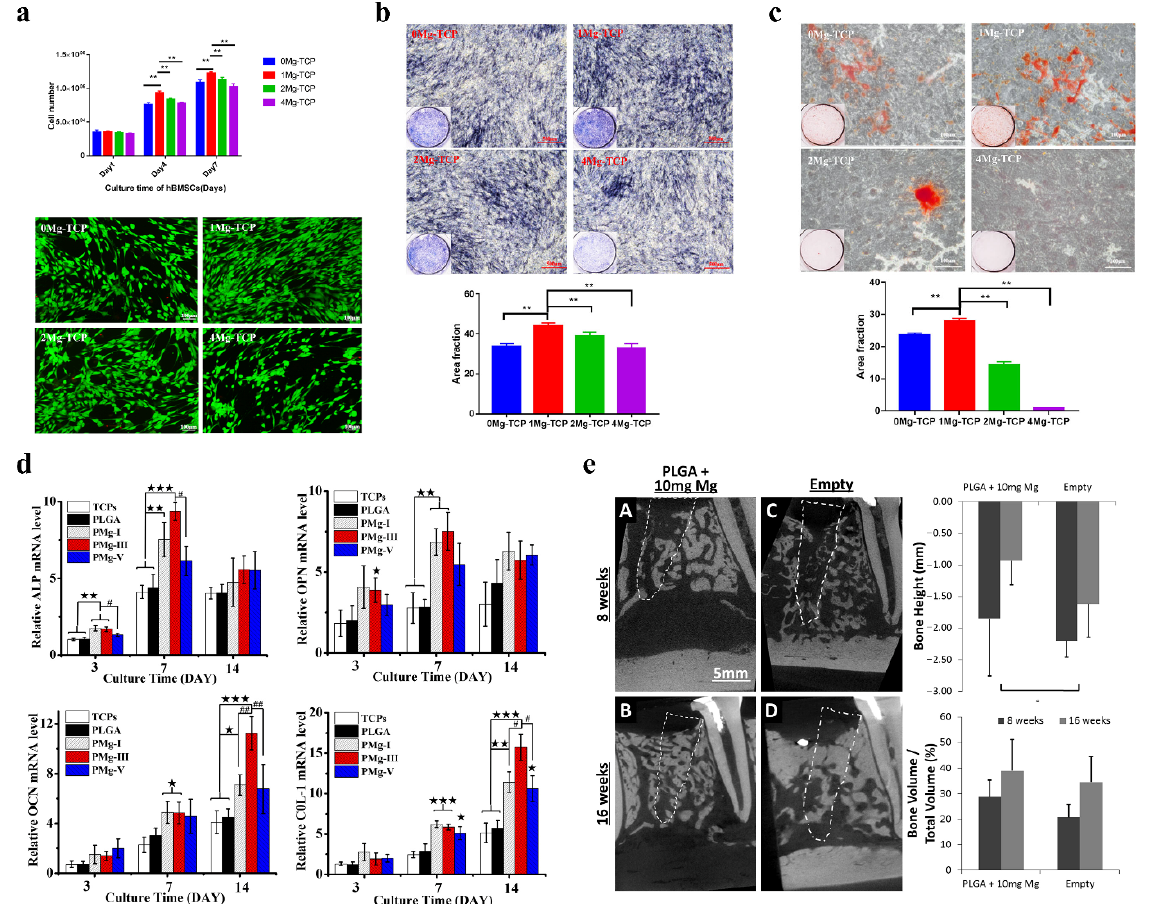
Figure 6. The osteopromitve performance of Mg both in vitro and in vivo. ( a ) The proliferation of hBMSCs after being co-cultured with Mg-doped β -TCP scaffold extracts for 7 days, as well as the fluorescence photographs of hBMSCs after 24 h culture. ** p < 0.01. ( b ) ALP staining and ( c ) ARS straining results of hBMSCs cultured in Mg-doped β -TCP scaffold extracts for 10 days and corresponding quantitative analysis data for positive area. Reproduced with permission from [112]. Copyright 2019, Springer Nature. ( d ) In vitro evaluation of the osteogenic differentiation of BMSCs cultured on PLGA or PMg size-III microspheres. TCPs were set as control group, and osteogenesis- related genes were examined by qPCR method. * , # ( p < 0.05), **, ## ( p < 0.01), *** ( p < 0.001). Reproduced with permission from [114]. Copyright 2018, Elsevier. ( e ) The micro-CT analysis, bone height, and bone volume/total volume (BV/TV) results of the PLGA + 10 mg Mg scaffolds implanted into canine pre-molar tooth sockets for 8 and 16 weeks. * p < 0.05. Reproduced with permission from [115]. Copyright 2014, Elsevier.